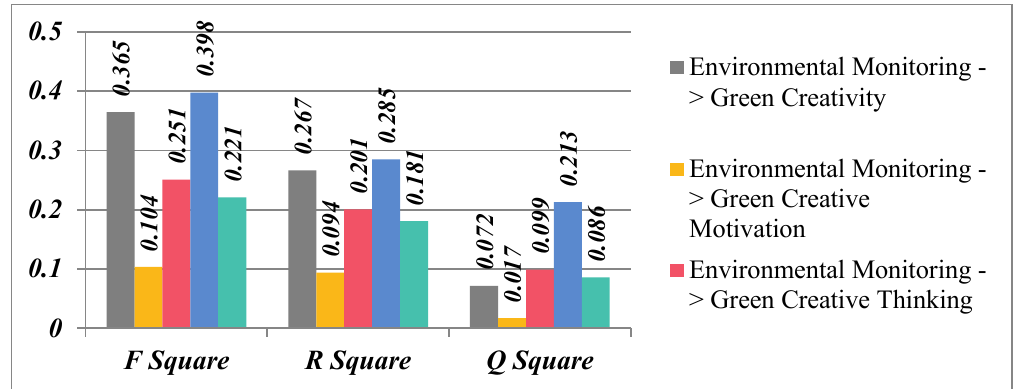
Fig. 4. Structural model assessment